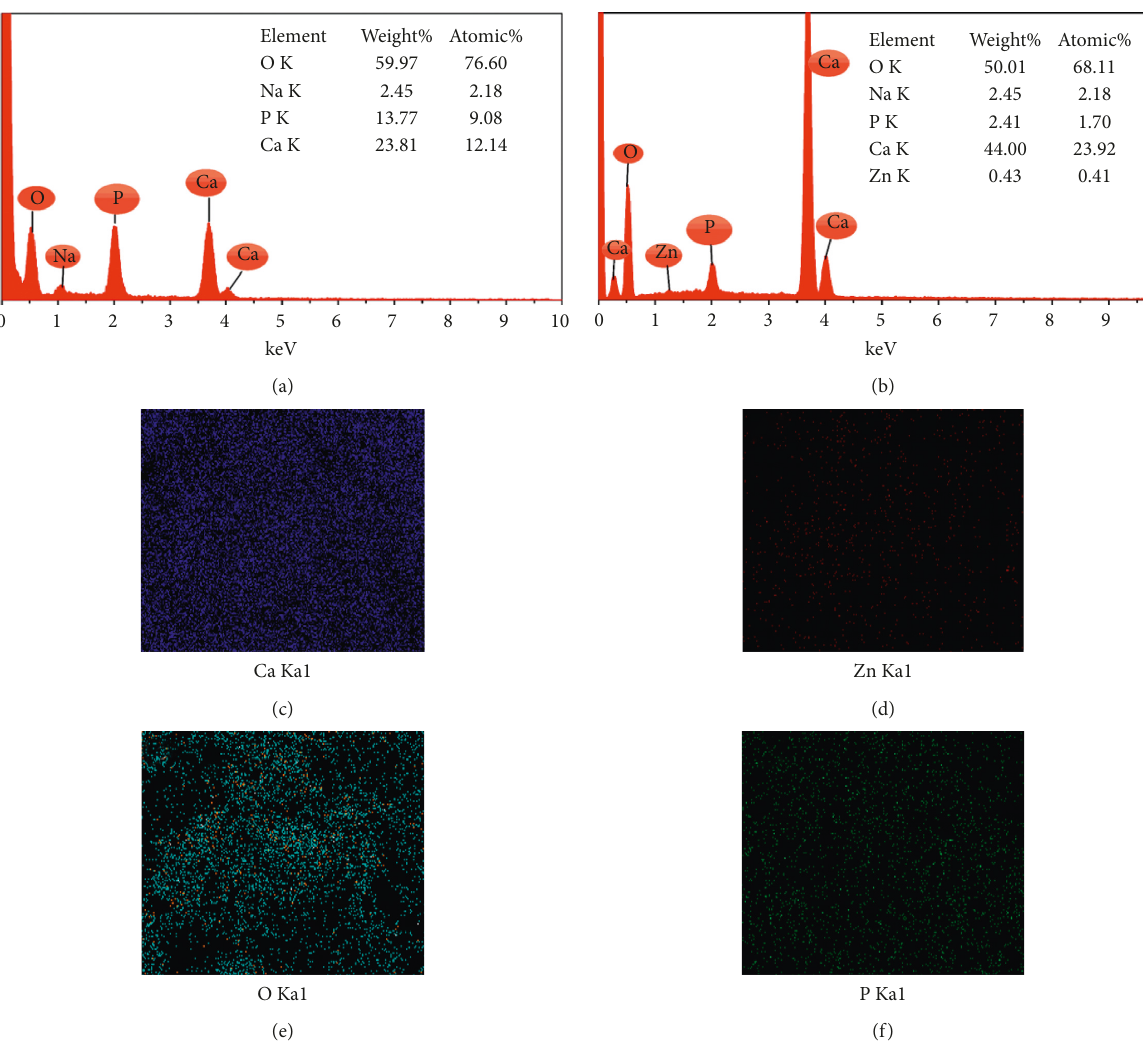
Figure 3: EDX patterns of HA (a) and Zn-HA (b), and element distribution on Zn-HA surface for calcium (c), zinc (d), oxygen (e), and phosphorus